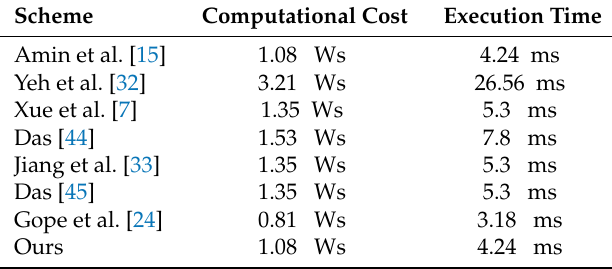
Table 5. Computational cost and execution time